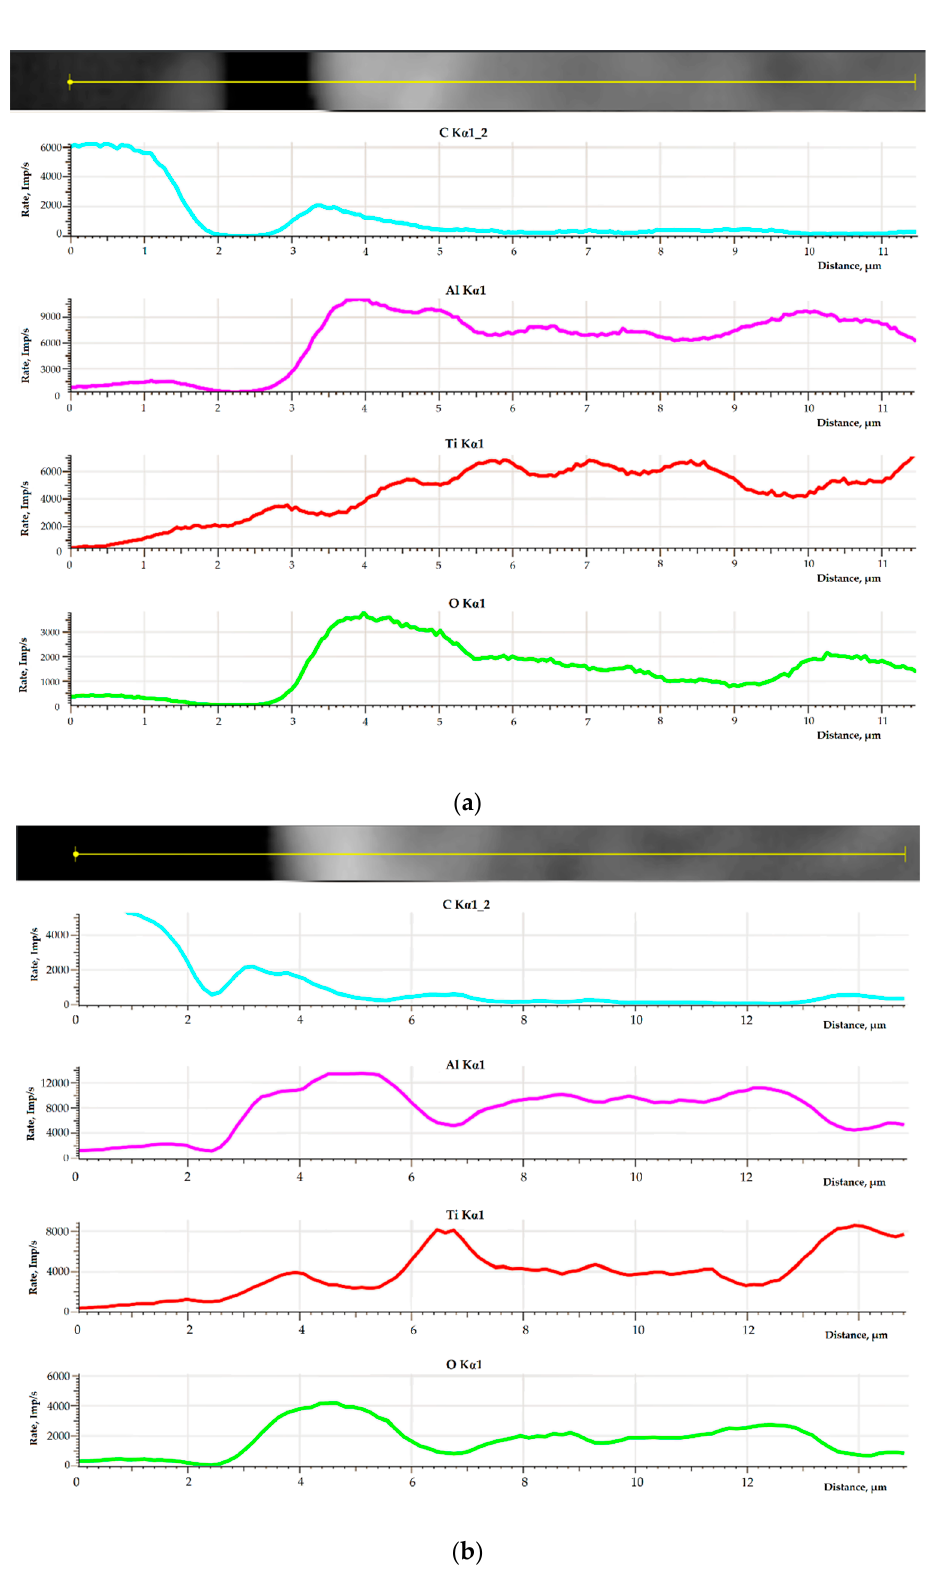
Figure 11. Chemical analyzes along the line of the Al 2 O 3 + 30%TiC nanocomposite cross-section after machining: ( a ) Oil; ( b ) water, where a blue line is for carbon, a fuchsia line is for aluminum; a red line is for titanium, and a green line is for oxygen.